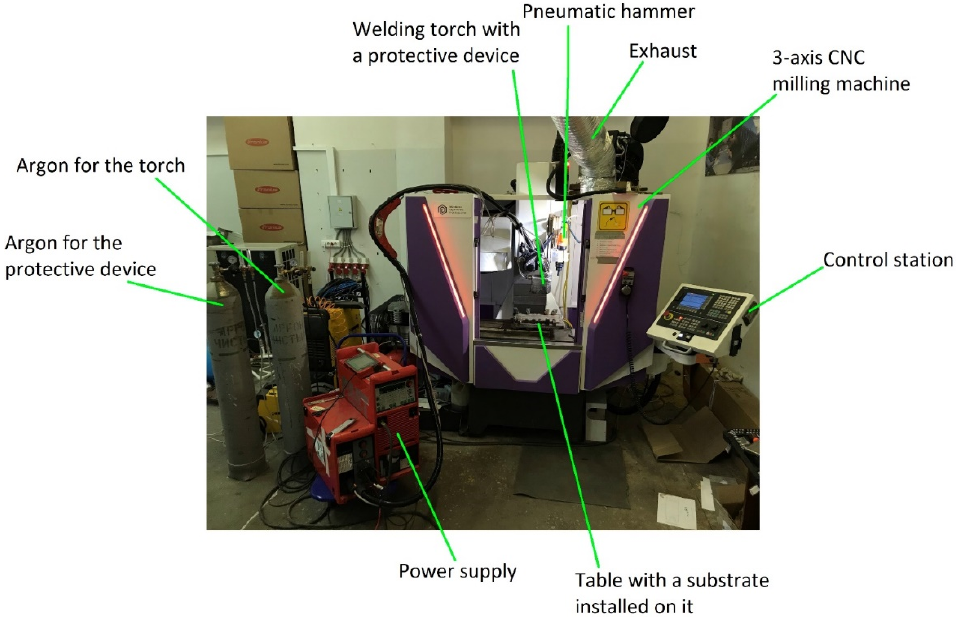
Figure 2. AT-300 machining center of the Hybrid Additive Manufacturing Group of Companies for the implementation of hybrid additive manufacturing technology.